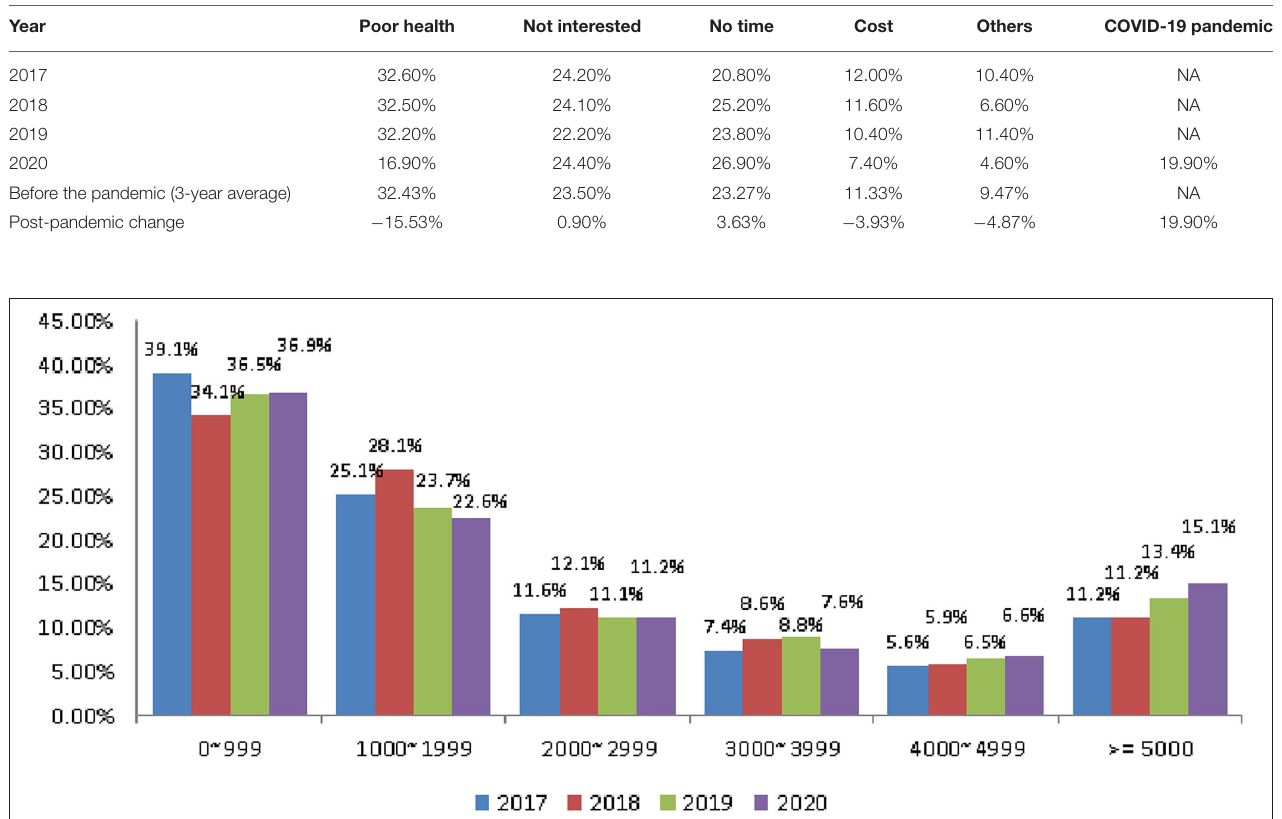
FIGURE 6 | The trend of tourism expenses. Currency unit is NT$. Exchange rate of NT$ to US$ is ∼ 0.035.